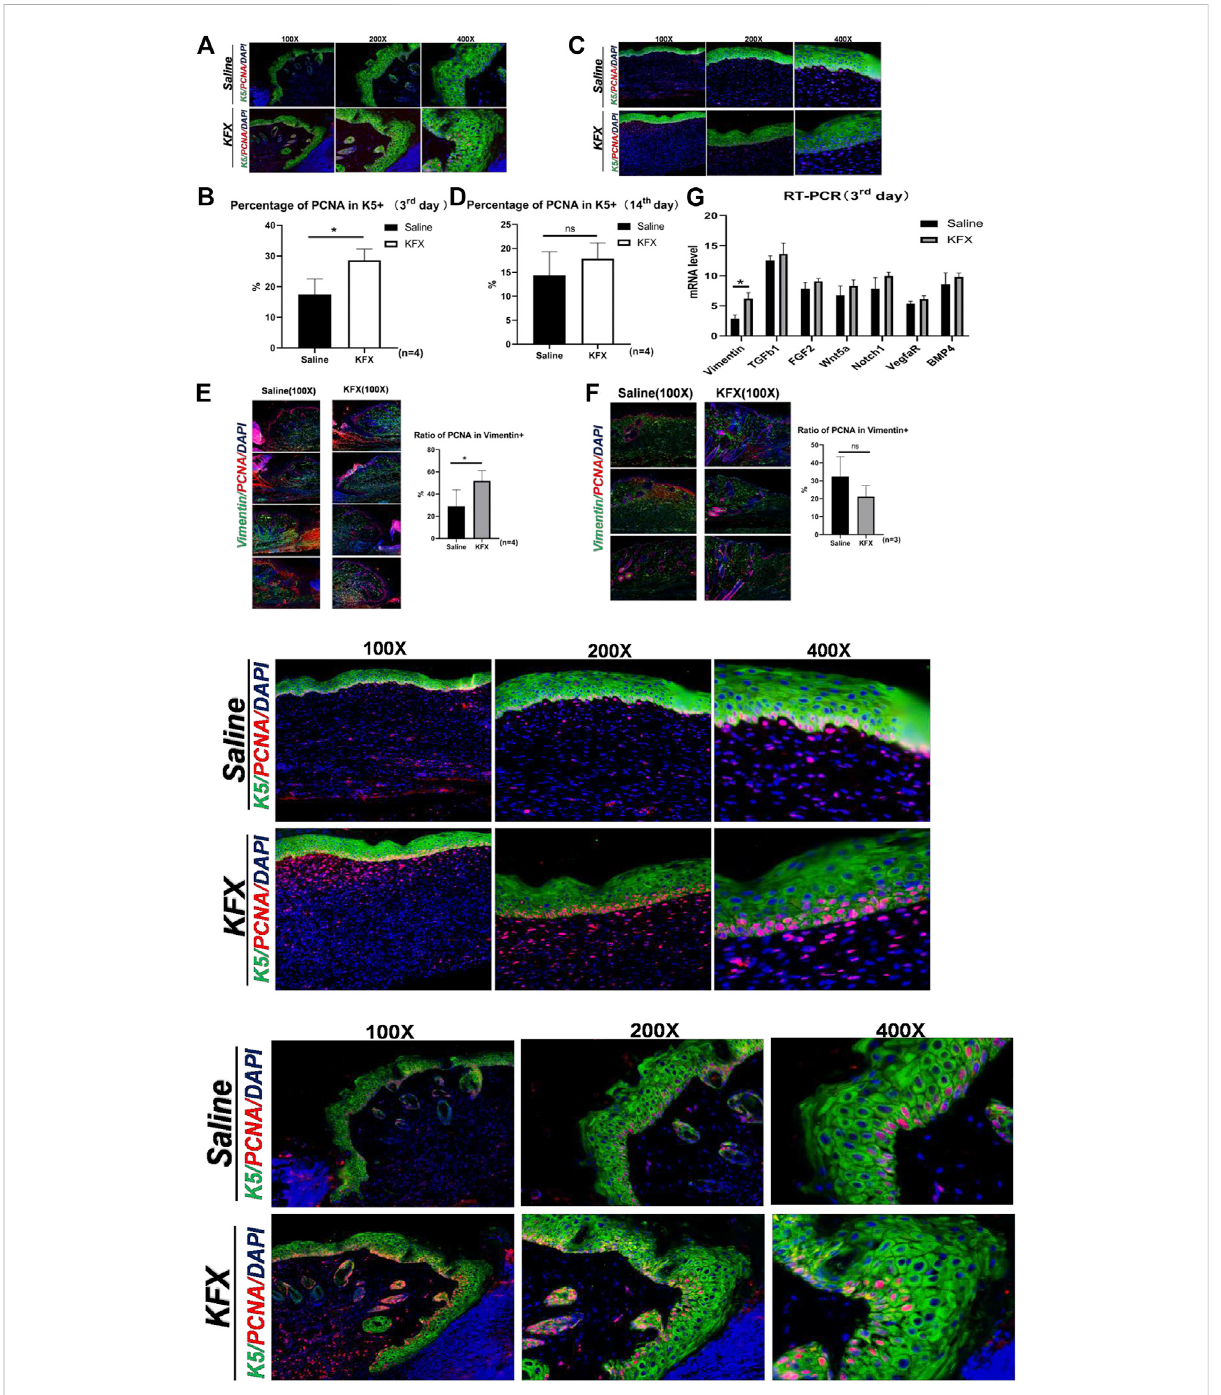
FIGURE 4 Expression of markers speci fi c to the proliferation of cutaneous cells in vivo as shown by immunohistochemical and RT-qPCR analysis. (A – D) IHCstainingoftheepidermal-cellmolecularmarkerCK5andcellproliferationmarkerPCNAondays3and14aftercutaneous-perforationwounding in the saline and KFX groups. (E – F) IF staining of the MSC-speci fi c marker vimentin and of PCNA on days 3 and 14 after cutaneous-perforation woundinginthesalineandKFXgroups. (G) QuantitativeassessmentofmRNAexpressionofgenesrelatedtocellproliferationanddifferentiation in various groups at day 3 after cutaneous-perforation wounding. The cell nucleus (blue fl uorescence) was stained with DAPI. Scale bars = 100×, 200×, and 400×. Data are shown as mean ± SD values. * p < 0.05, ** p < 0.01, *** p < 0.001 vs. the control group. NS, not signi fi